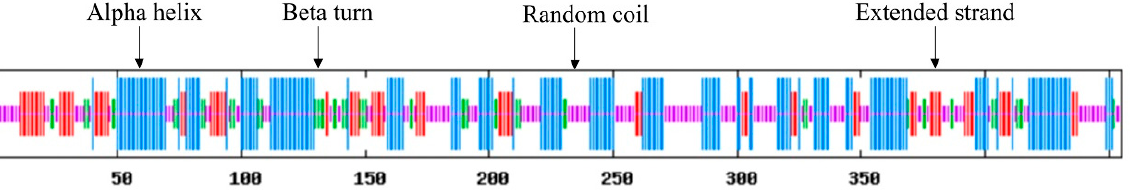
Figure 2. Secondary structure analysis of GhCIPK23 protein in upland cotton. The blue, green, purple and red lines represent alpha helix, beta turn, random coil and extended strand respectively.